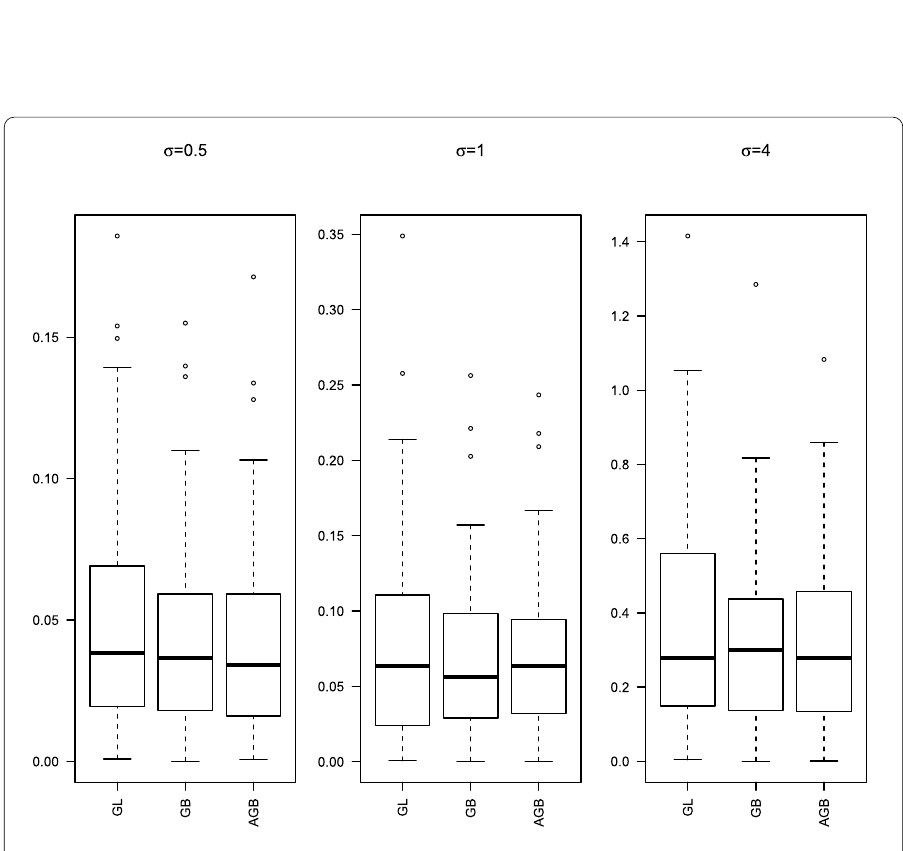
Figure 1 Boxplots of L 2 loss for p n =